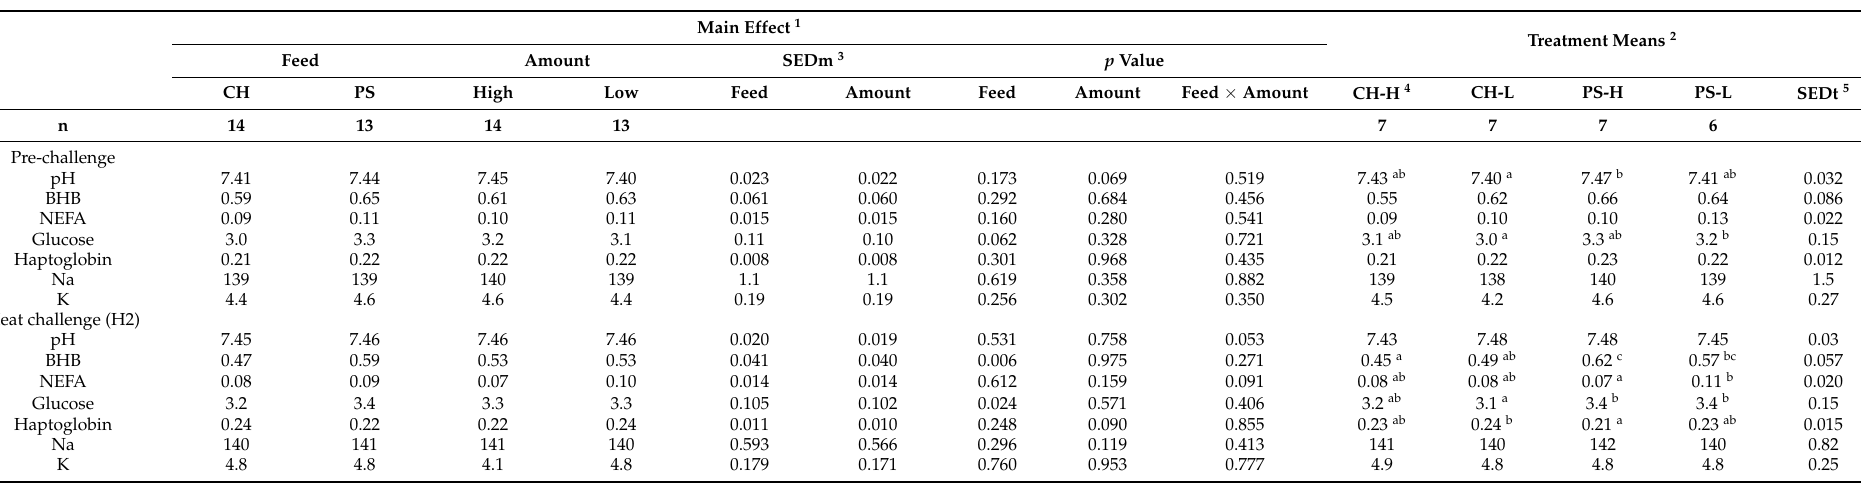
Table 9. Selected blood parameters during selected periods of the experiment. Blood pH and serum concentrations of beta-hydroxy butyrate (BHB;